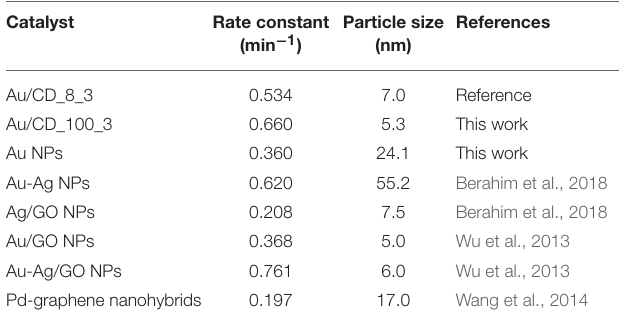
TABLE 8 | Comparison of the catalytic reduction of 4-NP by different noble metal